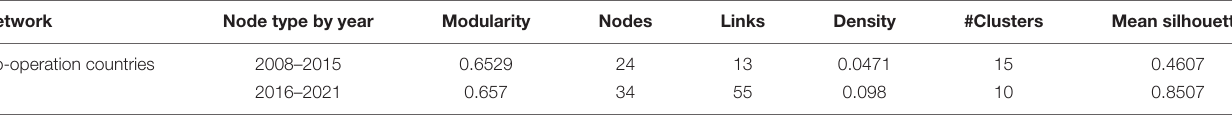
TABLE 4 | CiteSpace metrics by co-operation countries